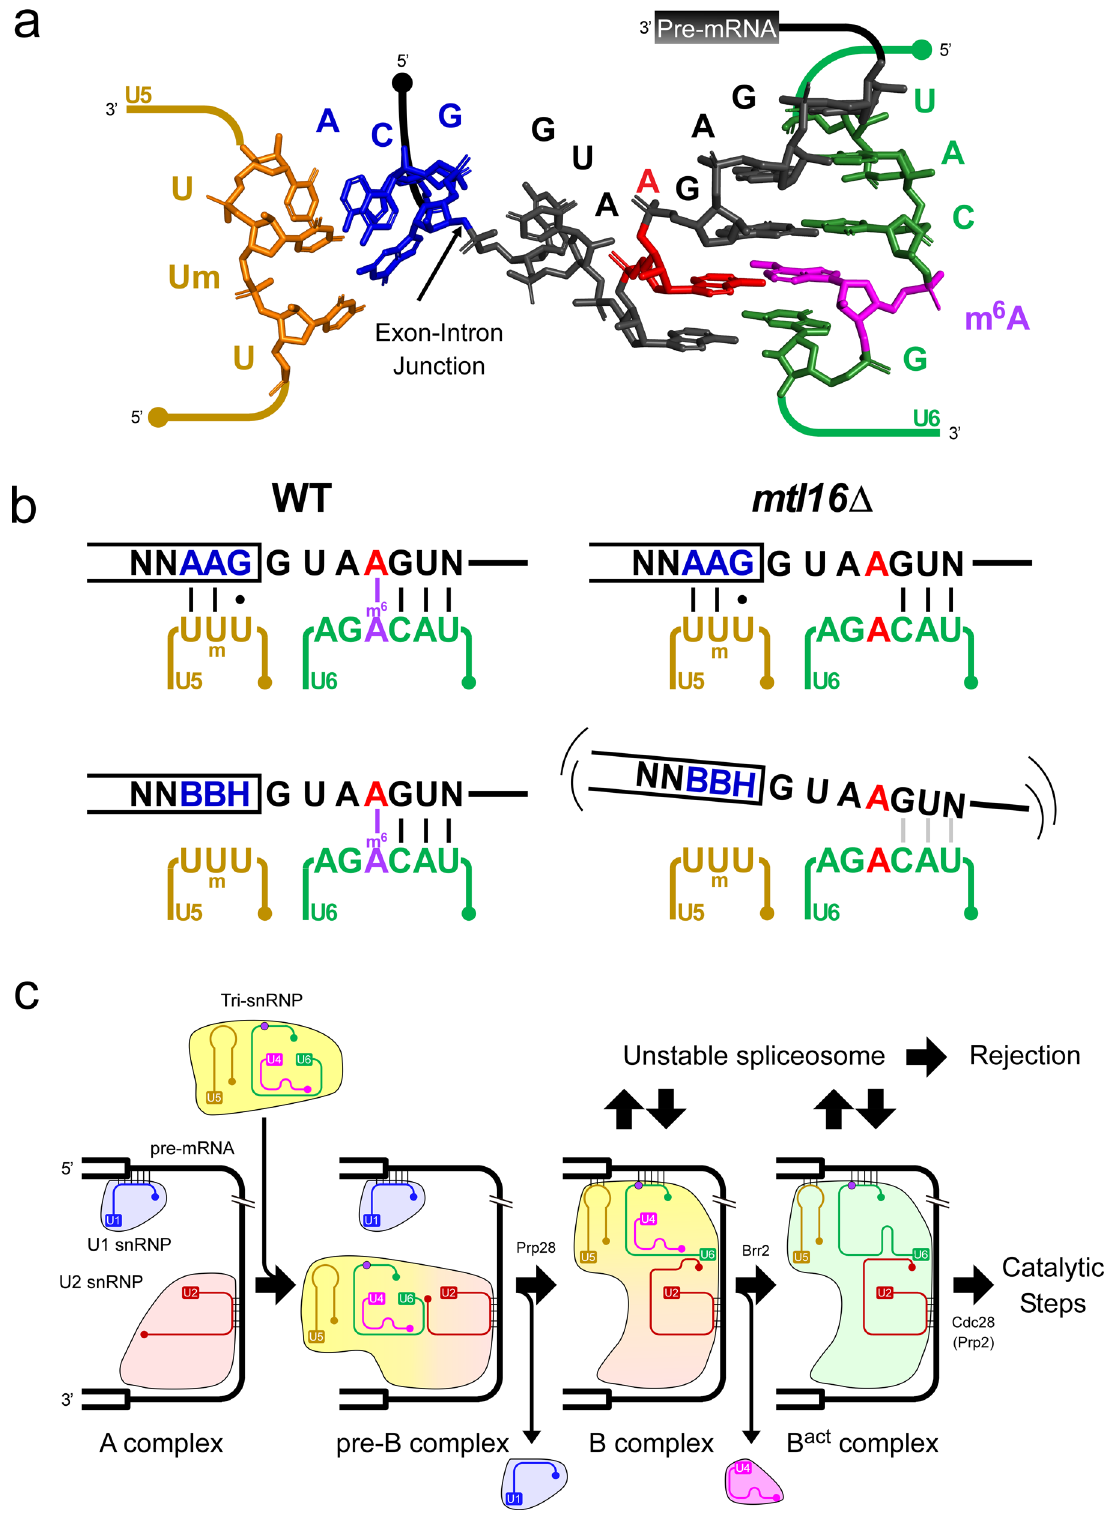
Fig. 5 Mechanistic insight into the functional role of U6 snRNA m 6 A modi fi cation on pre-mRNA splicing. a Cryo-EM structure of 5 ′ SS in the B complex of the human spliceosome (PDB ID:5O9Z) 92 , as depicted by PyMol 2.1.0 (http://www.pymol.org/2/support.html). The model consists of U5 snRNA (orange), U6 snRNA (green), 5 ′ exon (blue), intron (black), A4 (red), and m 6 A (magenta). The coordinate of the methyl group of m 6 A was set to its syn conformation. b Interaction between the 5 ′ SS of A4 intron and the U5 and U6 snRNAs in WT and mtl16 Δ strains. m 6 A – A pairing stabilizes the complex, especially when U5 snRNA recognizes the 5 ′ exon weakly. c Schematic depiction of spliceosomal assembly from A to B act complex based on cryo-EM structures of S. cerevisiae and human spliceosomes 83 – 86,91,92 . The m 6 A base in U6 snRNA is depicted by a dark-purple circle. The blue, red, yellow, purple, and green fi gures represent U1 snRNP, U2 snRNP, U4/U6.U5 tri-snRNP, U4 snRNP, and B act complex, respectively.